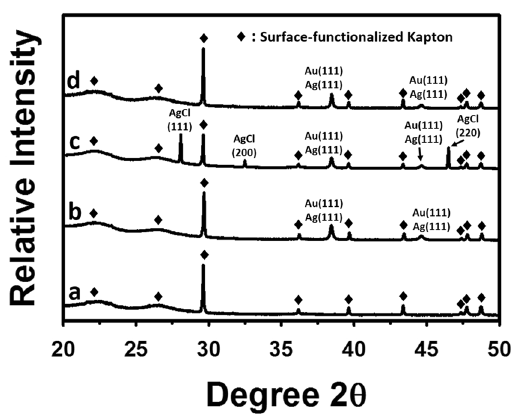
Figure 4. X-ray diffraction (XRD) analyses of ( a ) the starting Kapton ® substrate (functionalized with the SWCNT-selector complexes), ( b ) the inkjet-printed Kapton ® -Ag structure after the annealing but before the Ag-to-Au conversion, ( c ) the Kapton ® -IDE structure after the Ag-to-Au conversion but before the selective removal of the AgCl, and ( d ) The Kapton ® -IDE structure after the selective removal of the